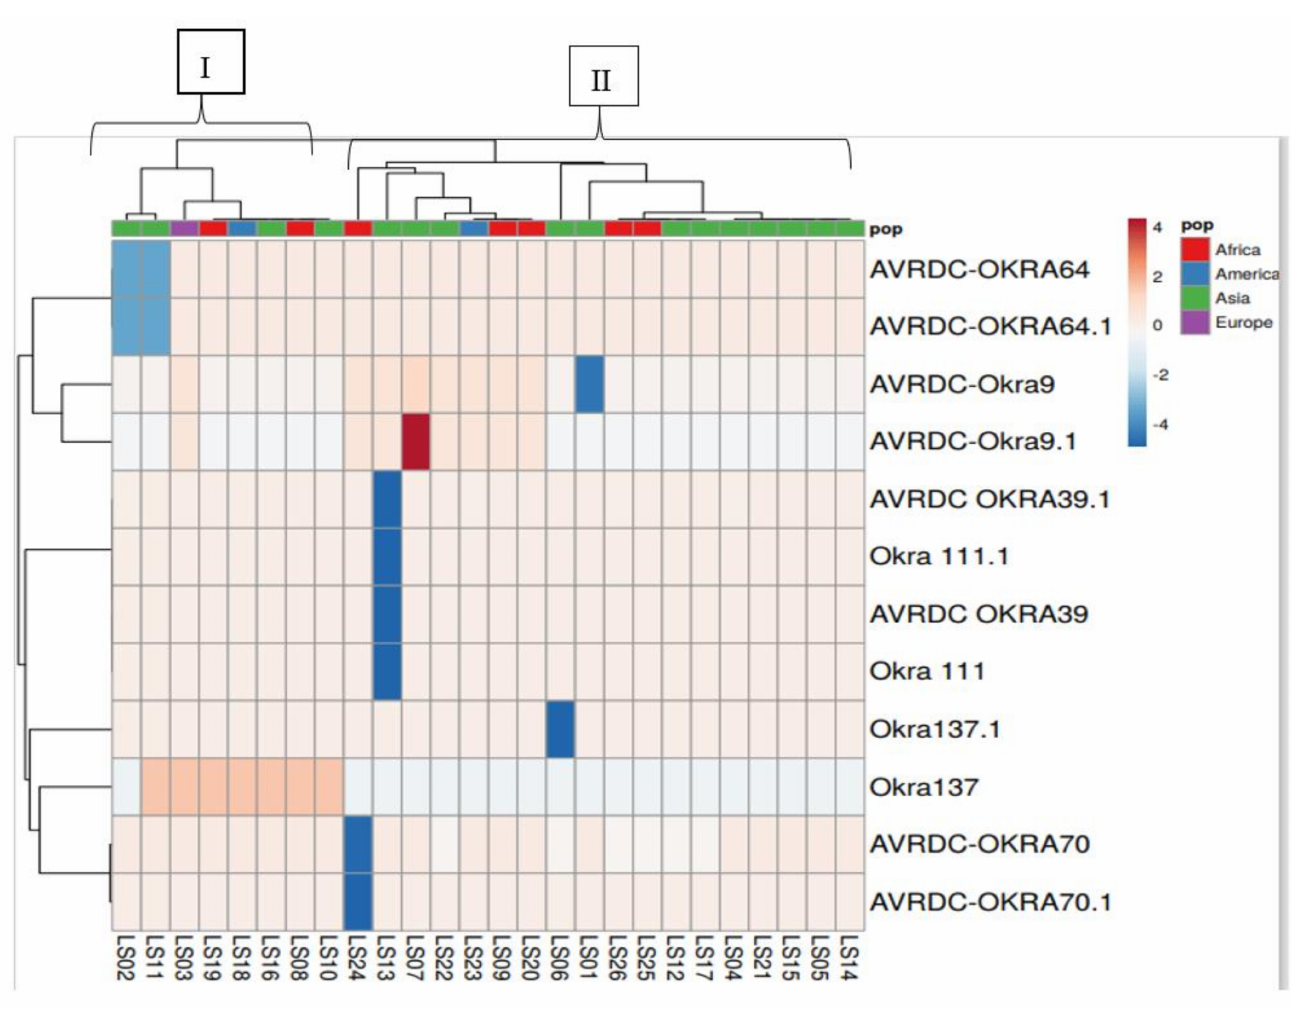
Figure 2. Heatmap showing the genetic relationship among 26 okra accessions using 9 SSR markers. Annotations in the heatmap show grouping of accessions and SSR marker